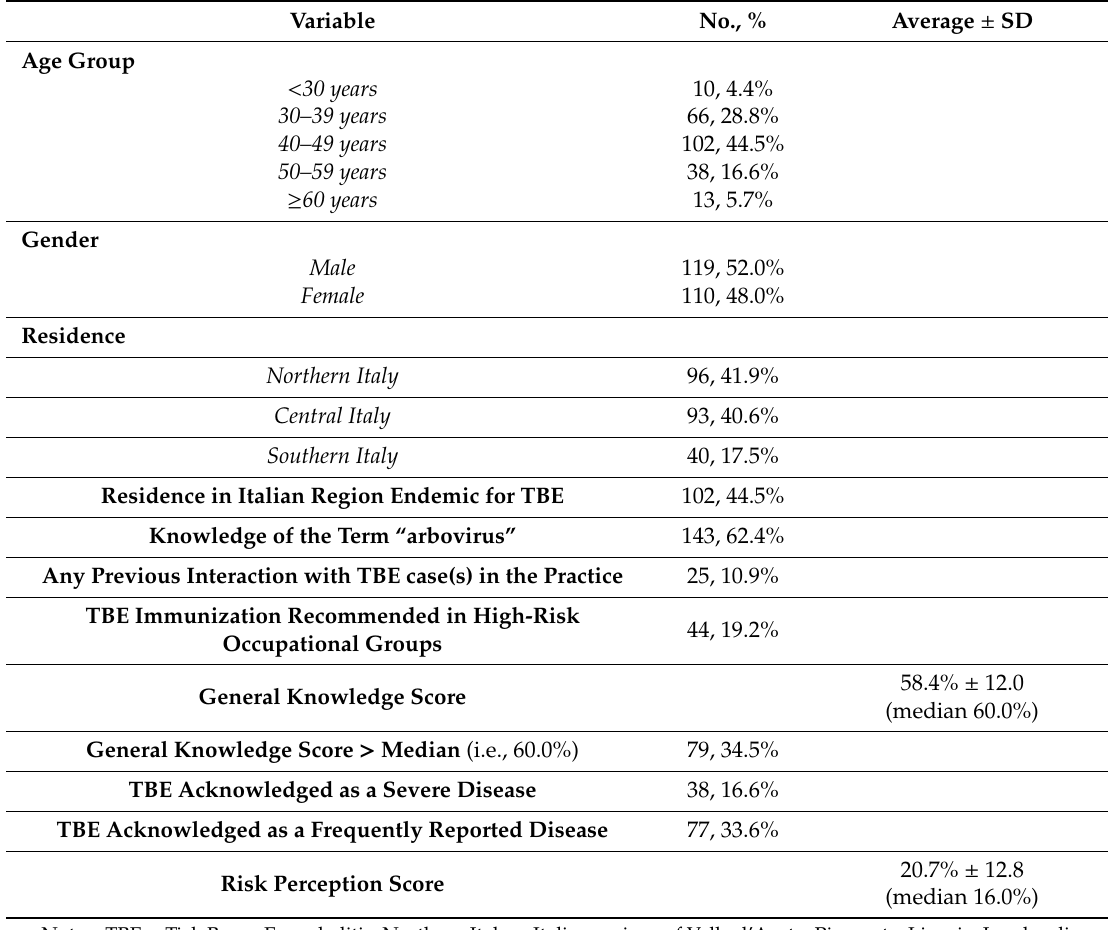
Table 1. Characteristics of 229 Italian occupational physicians participating in the survey (2020). Likert scale for perceived severity and perceived frequency of tick-borne encephalitis (TBE) in agricultural and forestry settings were dichotomized as “significant” and “very significant” (i.e., severe and frequently reported disease) vs. all other values (i.e., not severe and infrequently